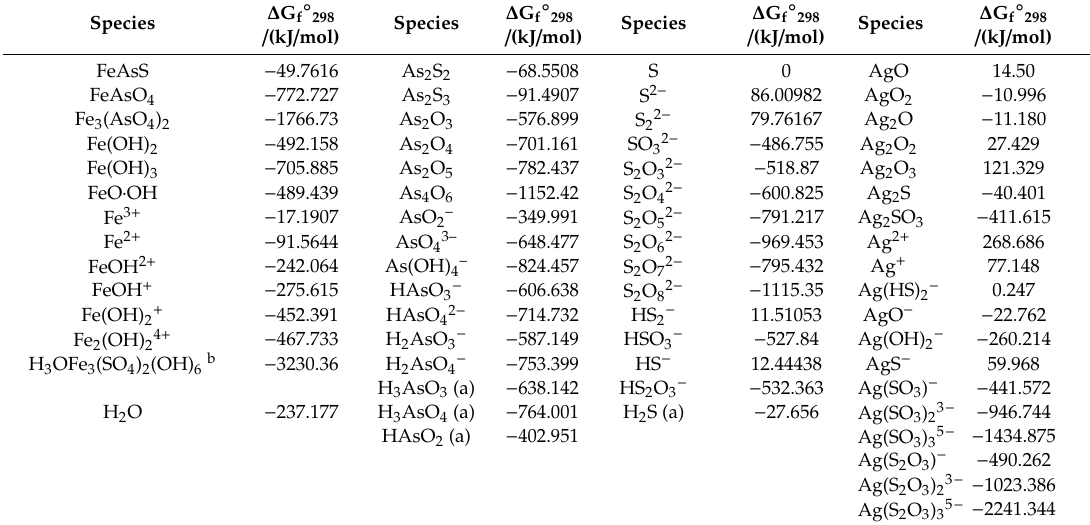
Table A1. Free energies of formation (kJ / mol) for relevant species a